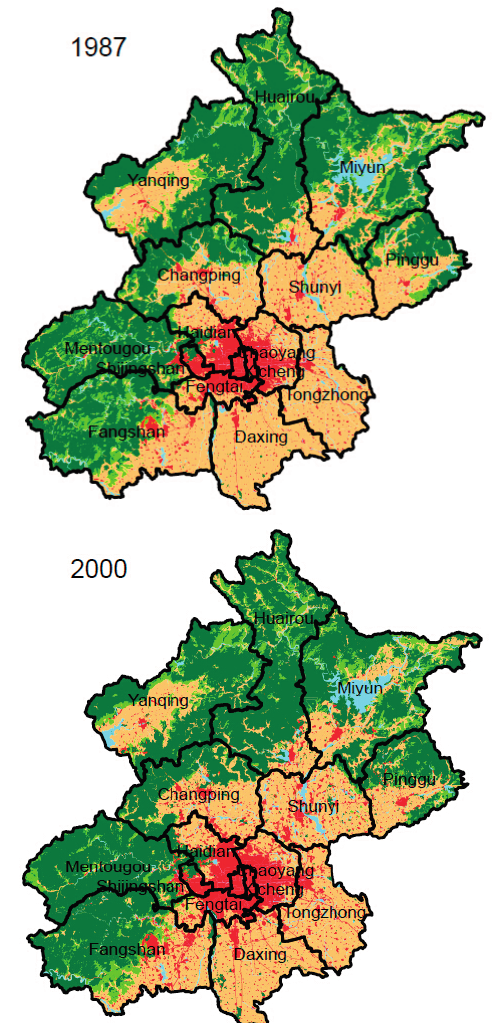
Figure 3. 1978–2010 LULC maps of